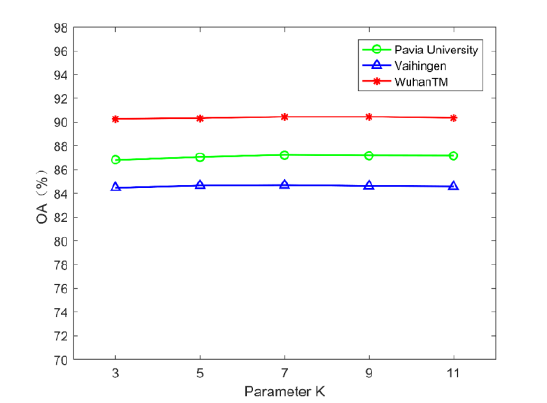
Figure 7. Relationship between classification accuracy (OA) and parameter